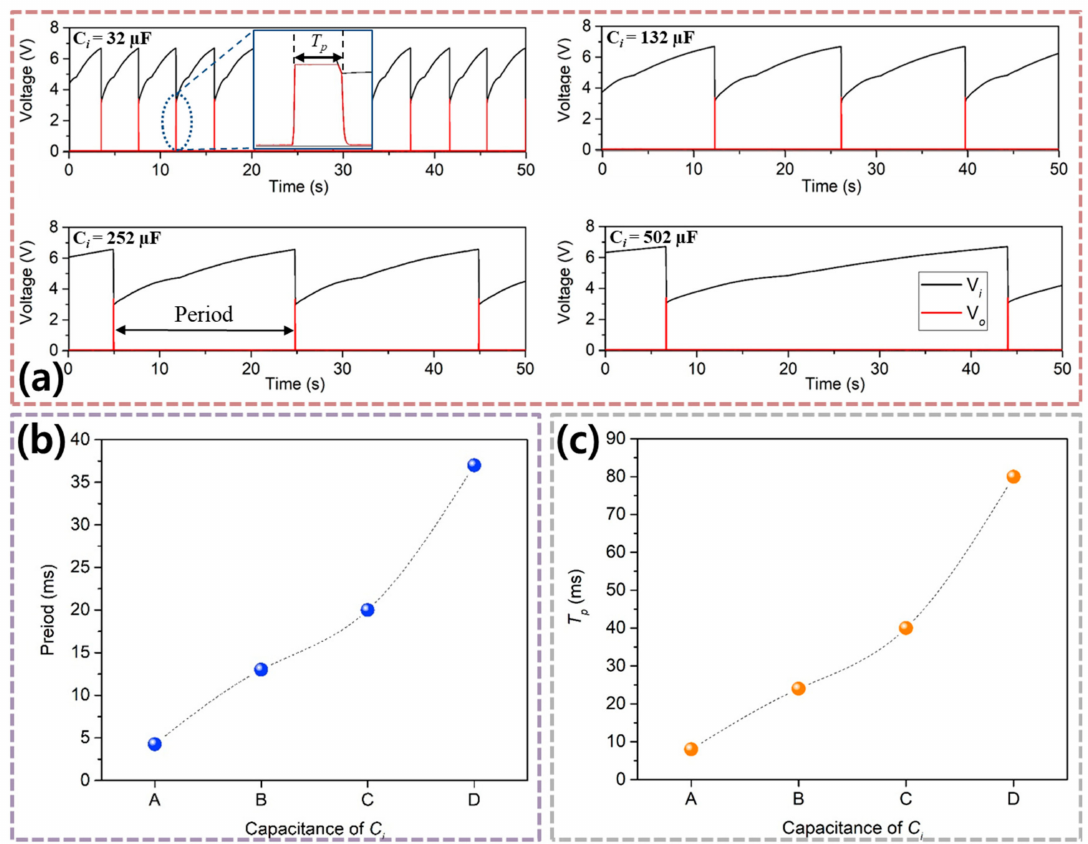
Figure 8. ( a ) Power transmission time and period as a function of the capacitance C i . ( b ) Period of the output voltage. ( c ) Power transmission time of the output voltage.